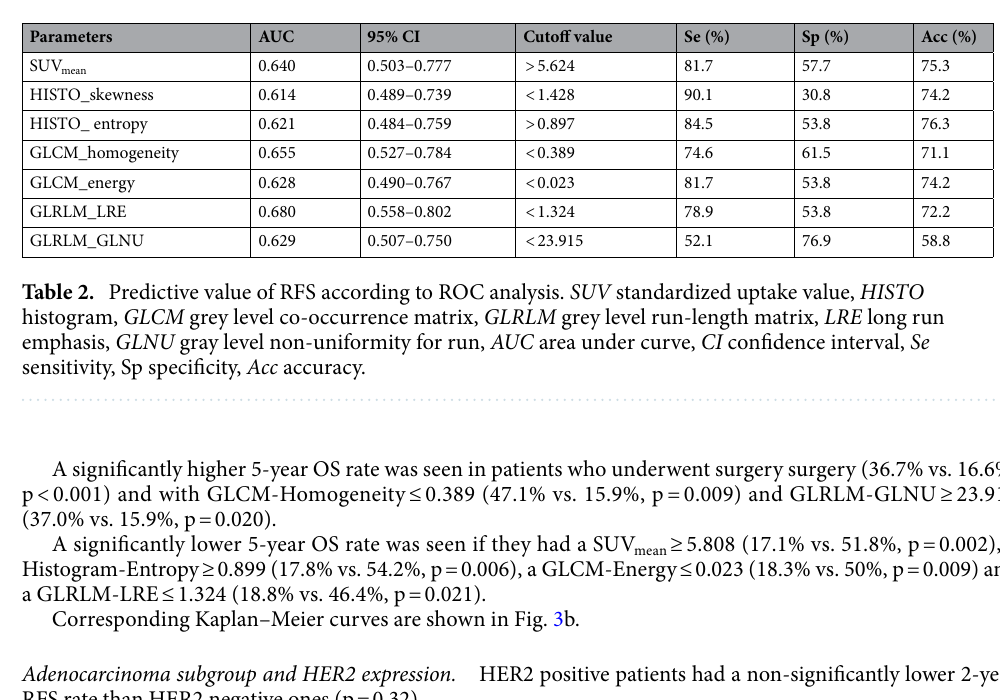
Figure 2. ROC curves with AUC to predict relapse free survival (RFS).